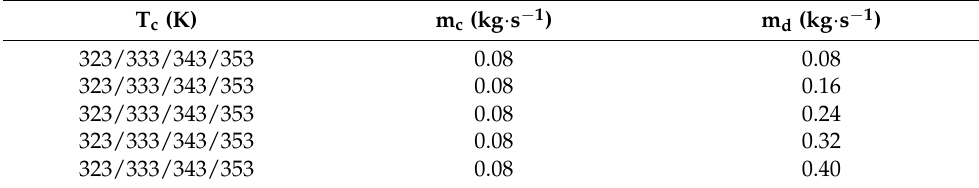
Table 3. Experimental